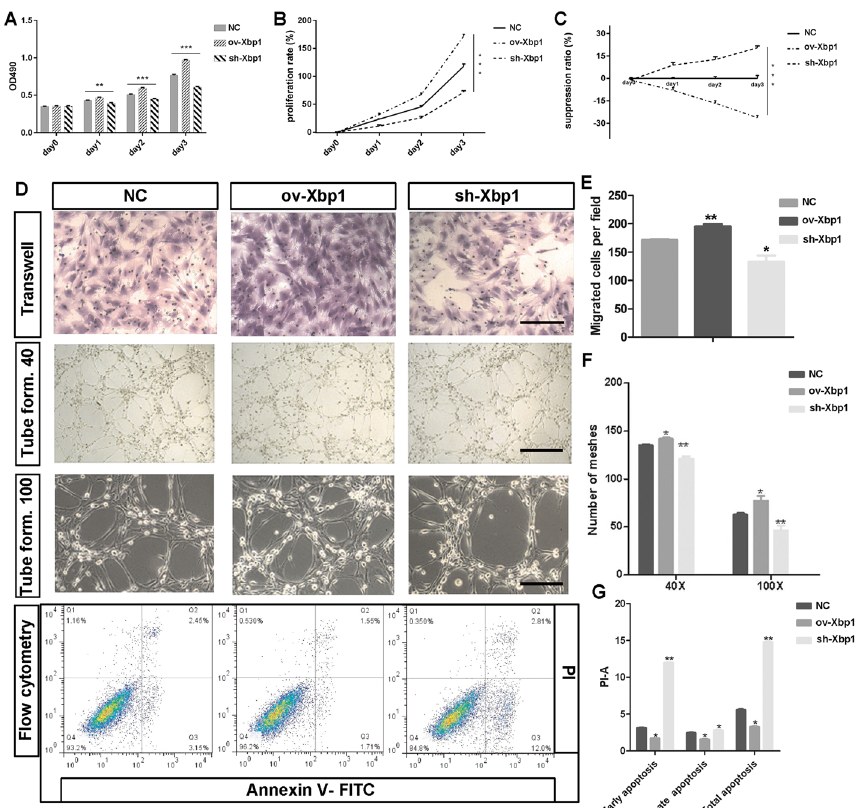
Fig. 4 In vitro assays confirming the roles of Xbp1 in improving survival and tube formation, and attenuating apoptosis in BMECs. A – C MTS assays measured the cell proliferation of brain microvessel endothelial cells (BMECs) after treatment with NC, sh-Xbp1, and ov-Xbp1 for different time intervals, 1 day, 2 days, and 3 days. NC was used as the control group. Proliferation rate (OD value/(OD value at day 0) 1) 100%. = − × Suppression ratio (1 experimental OD value/control OD value) 100%. Results are presented as = − × mean SD ( n 3 for each groups). One-way ANOVA followed by post hoc test. * P < 0.05, ** P < 0.01 compared ± = with the control. D Representative figures of Transwell (line 1, scale bar 25 μm), tube formation (line 2, scale bar 50 μm; line 3, scale bar 25 μm), and flow cytometry assays (line 4) under NC, ov-Xbp1, and sh-Xbp1 conditions. E Quantitative analysis Transwell assays that showed migration ability of infected BMECs. Results are presented as mean SD ( n 3 for each groups). One-way ANOVA followed by post hoc test. * P < 0.05 ± = compared to the control. F The effect of Xbp1 on the formation of tubes in BMECs was explored with the Matrigel assay at magnifications of 40 (tube formation 40) and 100 (tube formation 100). Results are × × presented as